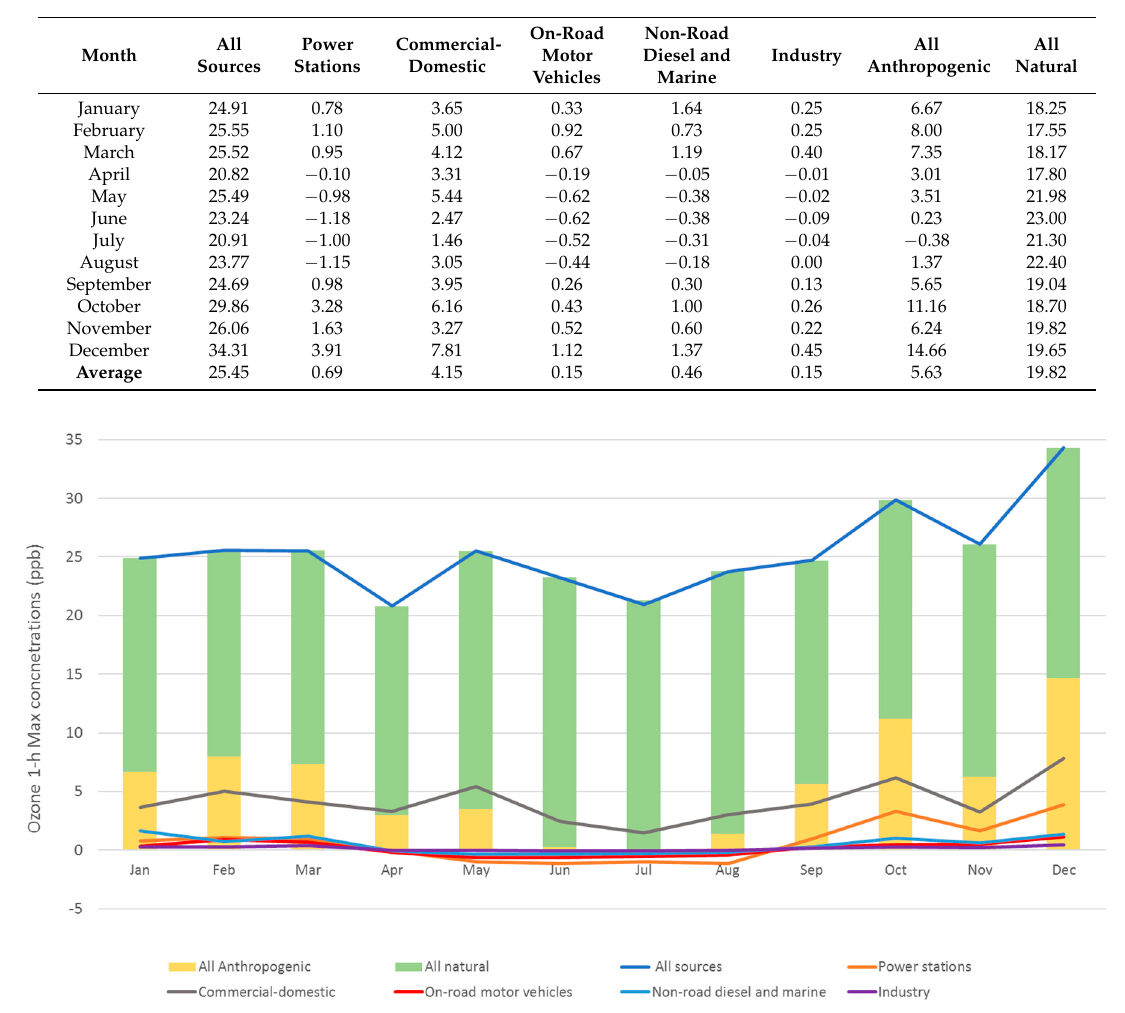
Figure A9. Contribution of all anthropogenic and natural emissions (bar graph) and different anthropogenic sources (line graph) to the monthly average of daily maximum 1-hour ozone concentration in 2008 in the Newcastle region.